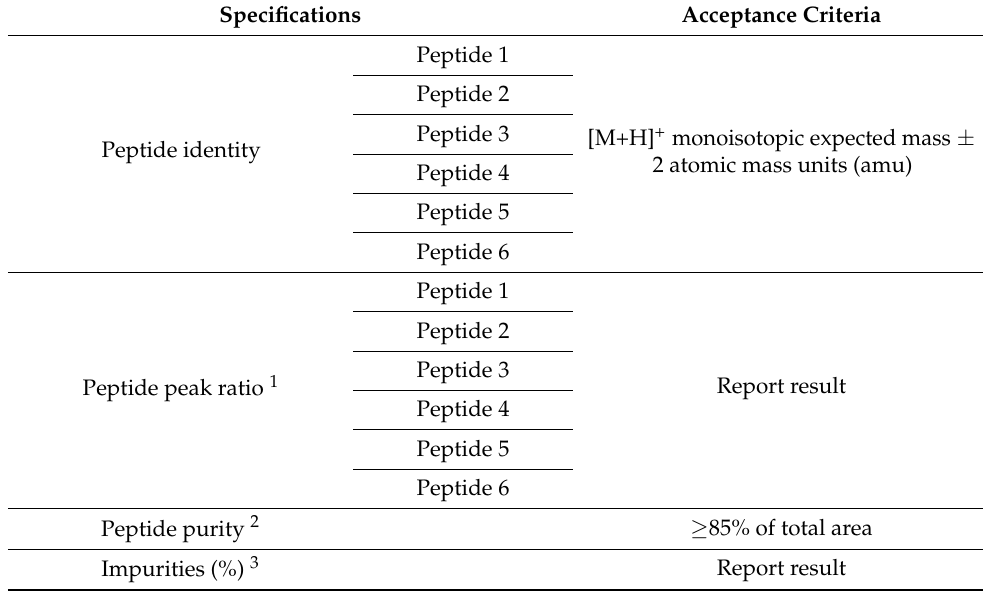
Table 1. The specifications and acceptance criteria of the peptide mixtures that will be formulated together with the adjuvant Montanide into